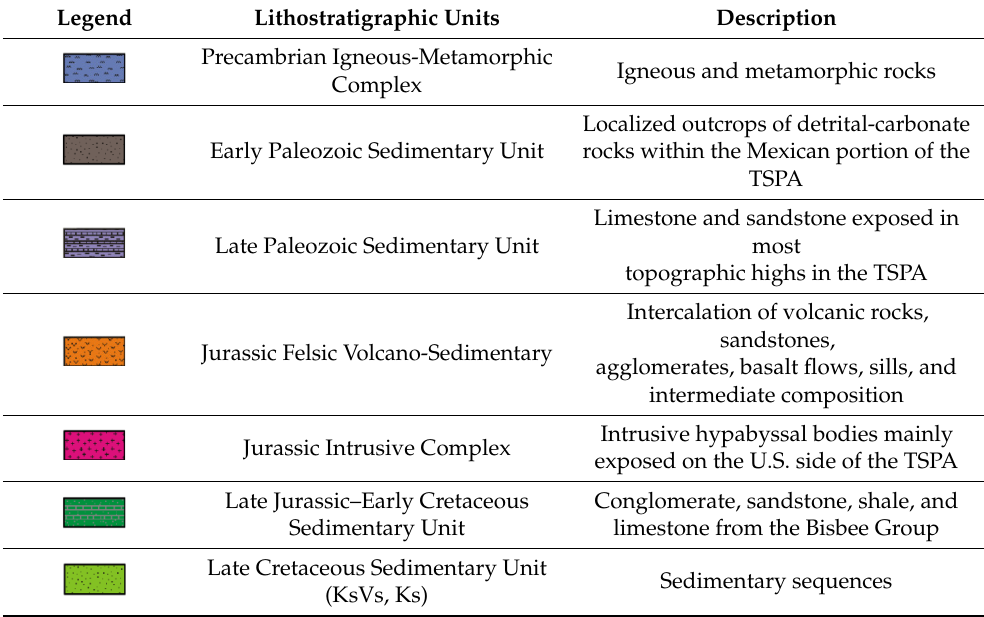
Table 2. Lithological units in the TSPA. Source: Authors’ development based on Callegary et al. (2016)